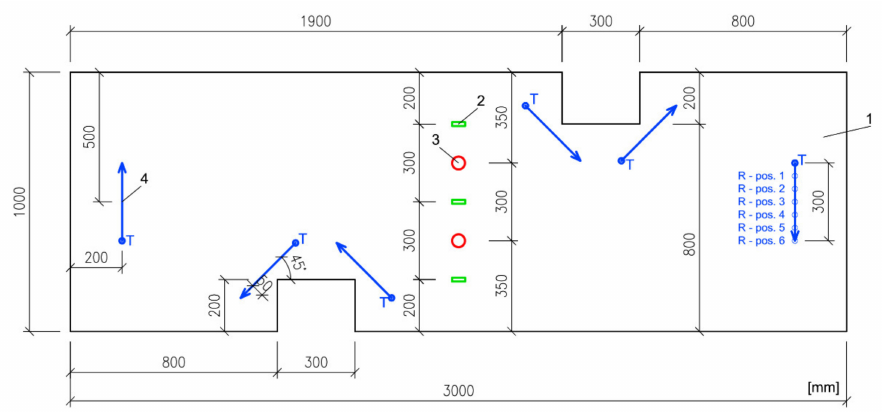
Figure 3. Tile dimensions (1) including the positions of the cutouts, strain gauges (2), acoustic emission (AE) sensors (3) and measurement lines for the ultrasonic pulse velocity (UPV) test (4) with the position of the transmitter (T) and, for illustration, receiver positions indicated at one of the lines